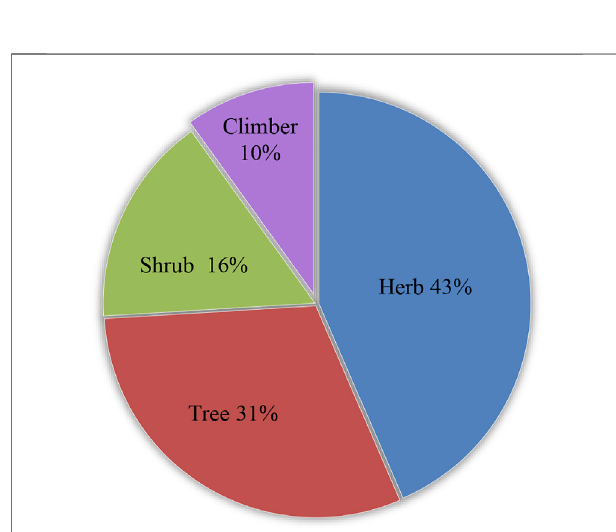
FIGURE 2 | Family of medicinal plants with a high number of genera and species.